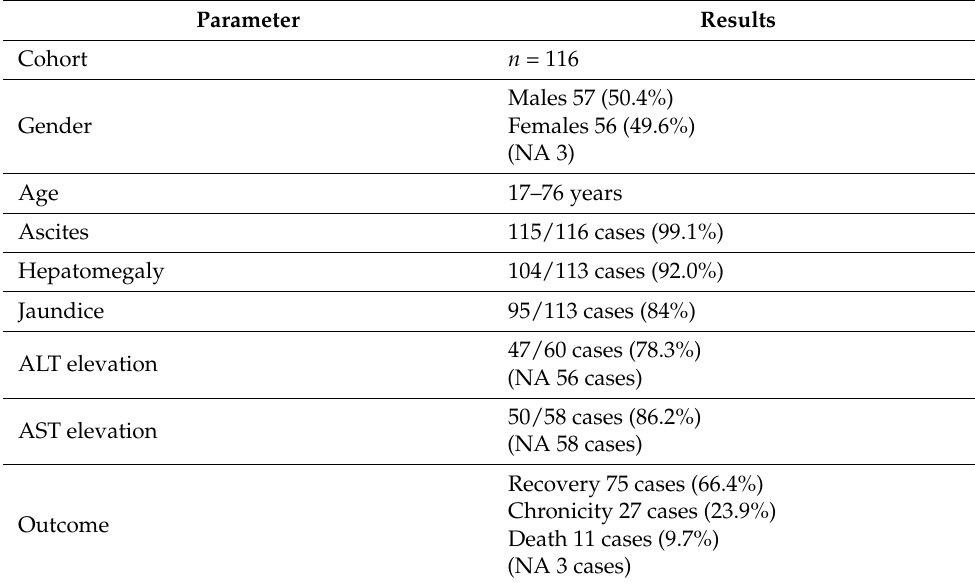
Table 5. Clinical characteristics of the HSOS caused by Gynura segetum containing unsaturated PAs. Parameter